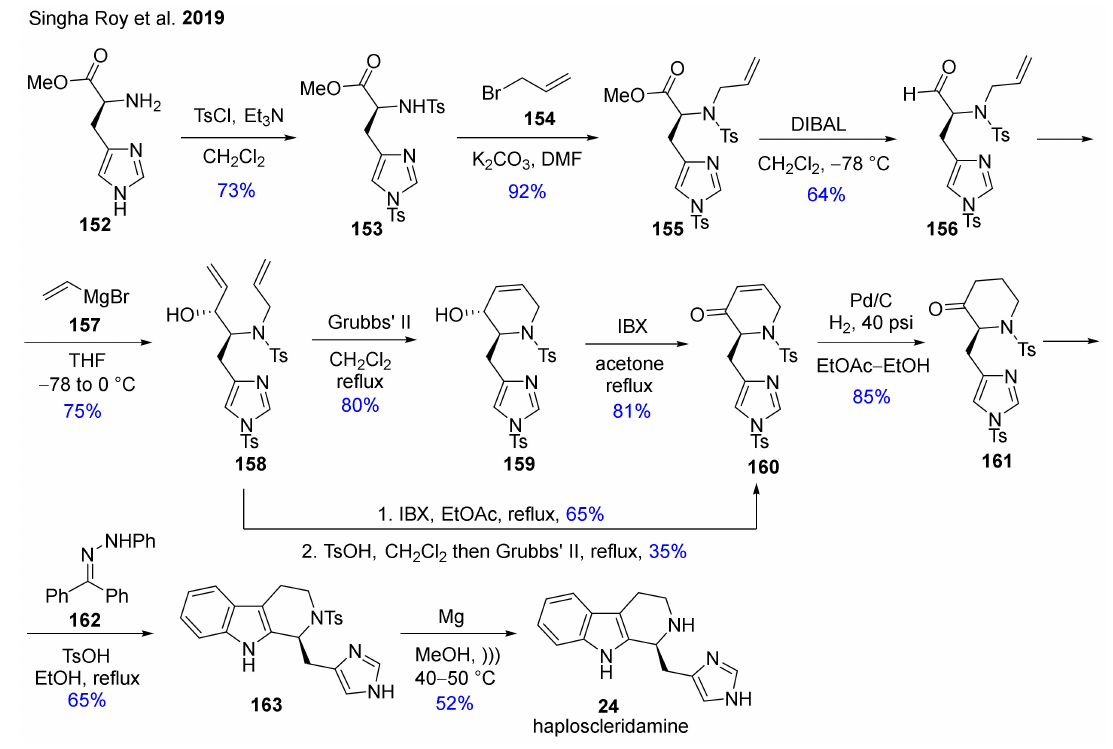
Scheme 12. Synthesis of haploscleridamine ( 24 ).